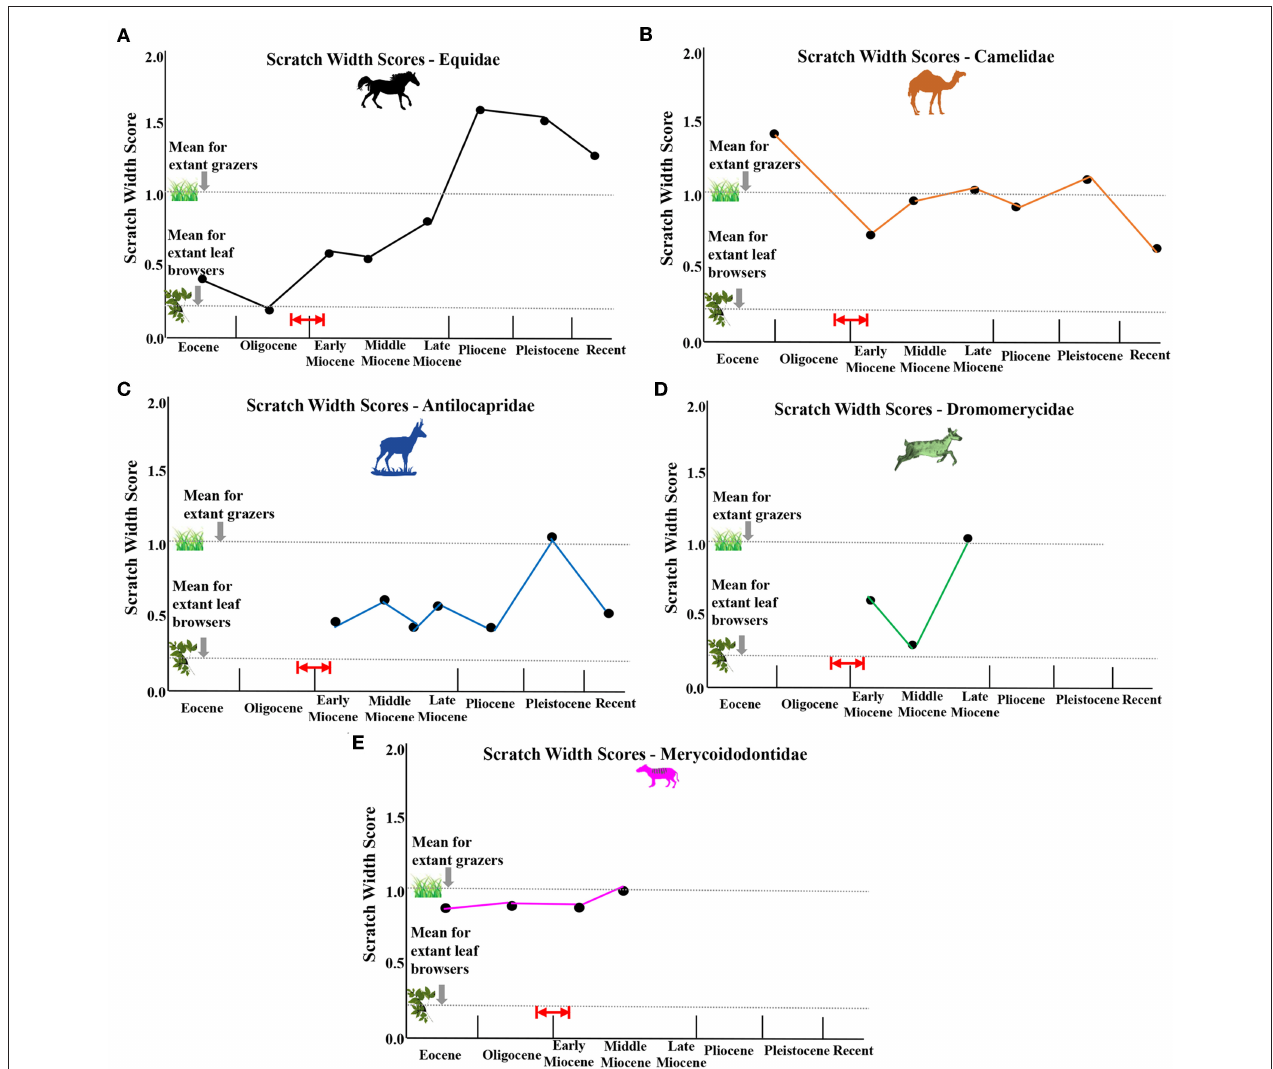
FIGURE 7 | Average scratch width scores (sws) for each fossil family plotted over evolutionary time. (A) equids, (B) camelids, (C) antilocaprids, (D) dromomerycids, (E) merycoidodontids. Red arrow and red lines indicate probable timing of first availability of grass in the North American Great Plains Region by ∼ 22 million years ago (earliest Miocene), but possibly by even about 26 million years ago (latest Oligocene) based on phytolith data from Strömberg